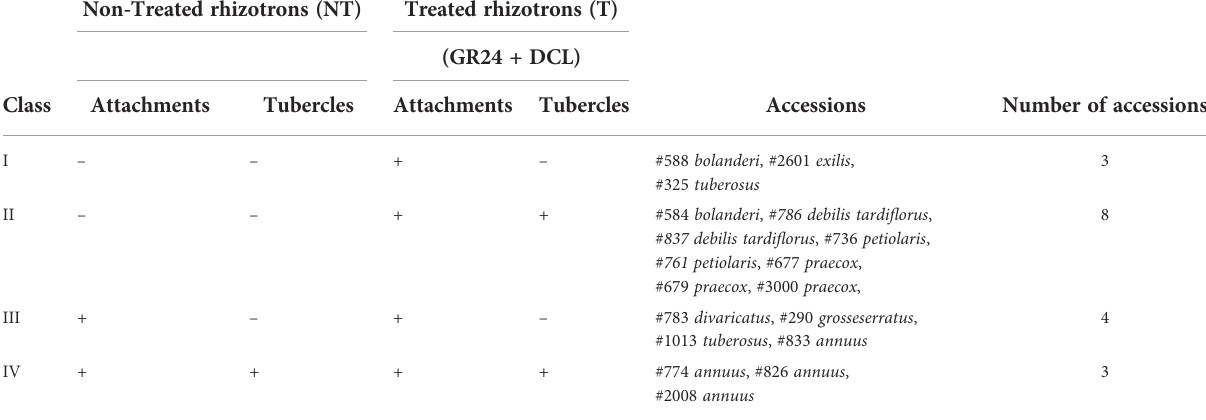
TABLE 5 Four phenotyping classes in rhizotrons of 18 wild Helianthus accessions, using the broomrape race E-BOU. Non-Treated rhizotrons